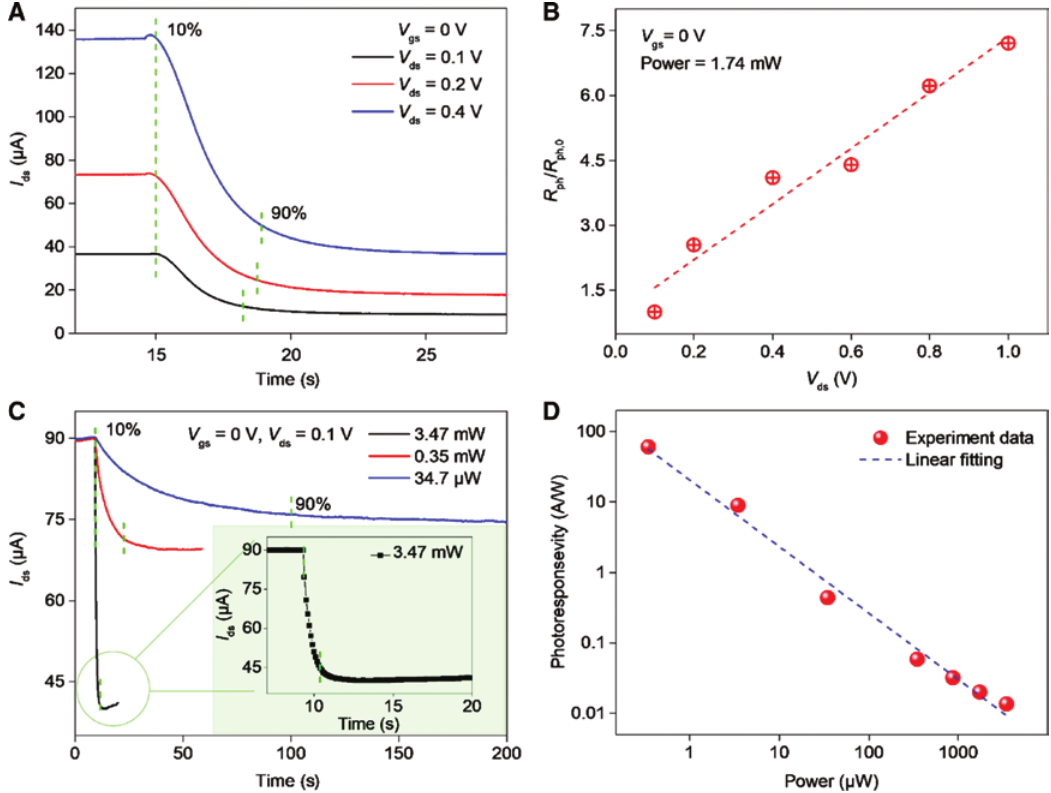
NPs decorated GFET photodetectors. 2 = 0 V) and an incident laser power ), under the conditions of zero gate bias ( V ds gs = 0.1 V] as a function of / R , where R is the photoresponsivity ( R ) obtained at V ph ph,0 ph,0 ph ds = 0 V. (C) Photoresponses under different incident laser powers. gs = 0.1 and V = 0 ds gs